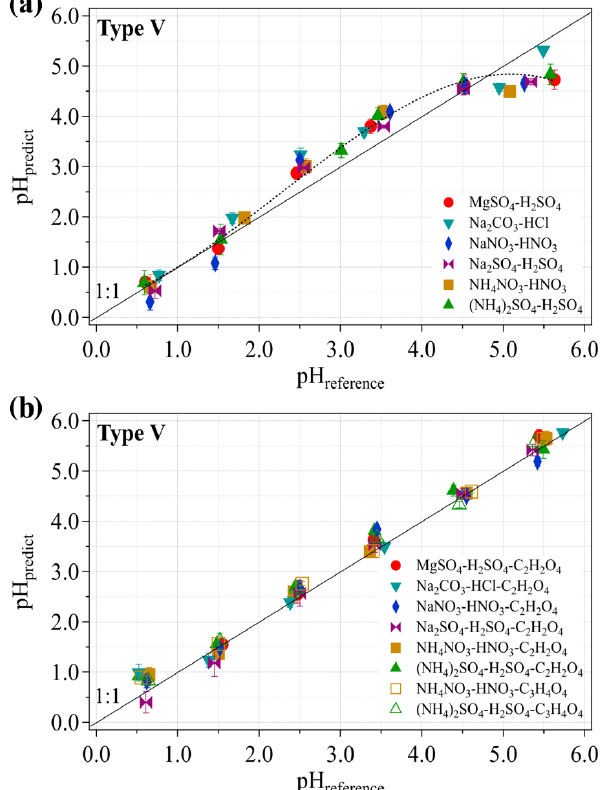
Figure 3. pH estimation using the type V pH paper for samples with different volumes: (a) 2µL and (b) 0.1µL. pH predict is calculated with the averaged coefficient vector [ a , b , c ] derived from three to six replicate experiments with the same amounts of standard buffers as the samples under constant photographing conditions. The error bars represent the SD of three to six replicate experiments. In (a) , the heights of the orange and blue bars indicate the reported pH ranges measured with pH papers and Raman spectroscopy, respec- tively, for ( NH 4 ) 2 SO 4 − H 2 SO 4 aerosols with particle sizes larger than 2.5µm in Craig et al. (2018). Each orange or blue bar has the same pH reference as the red symbol close to it. In (b) , for processing the digital images of the 0.1µL samples, a square with 20 × 20pixels at the center of the samples is cropped for subsequent colorimetric analyses.